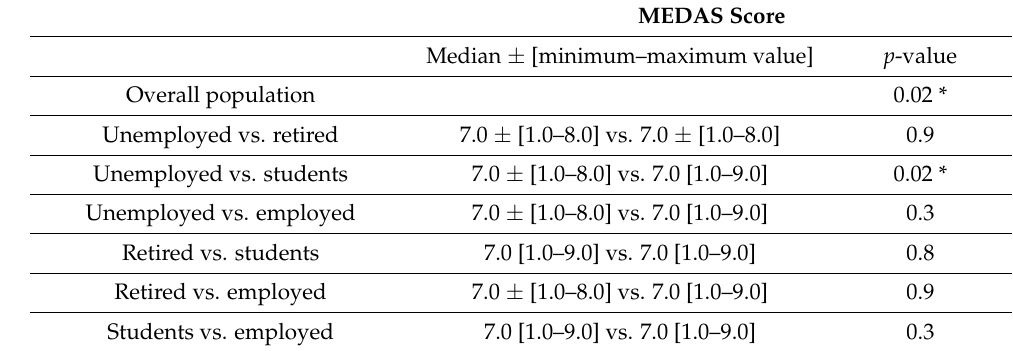
Table 6. Comparisons between occupation groups for the MEDAS score.